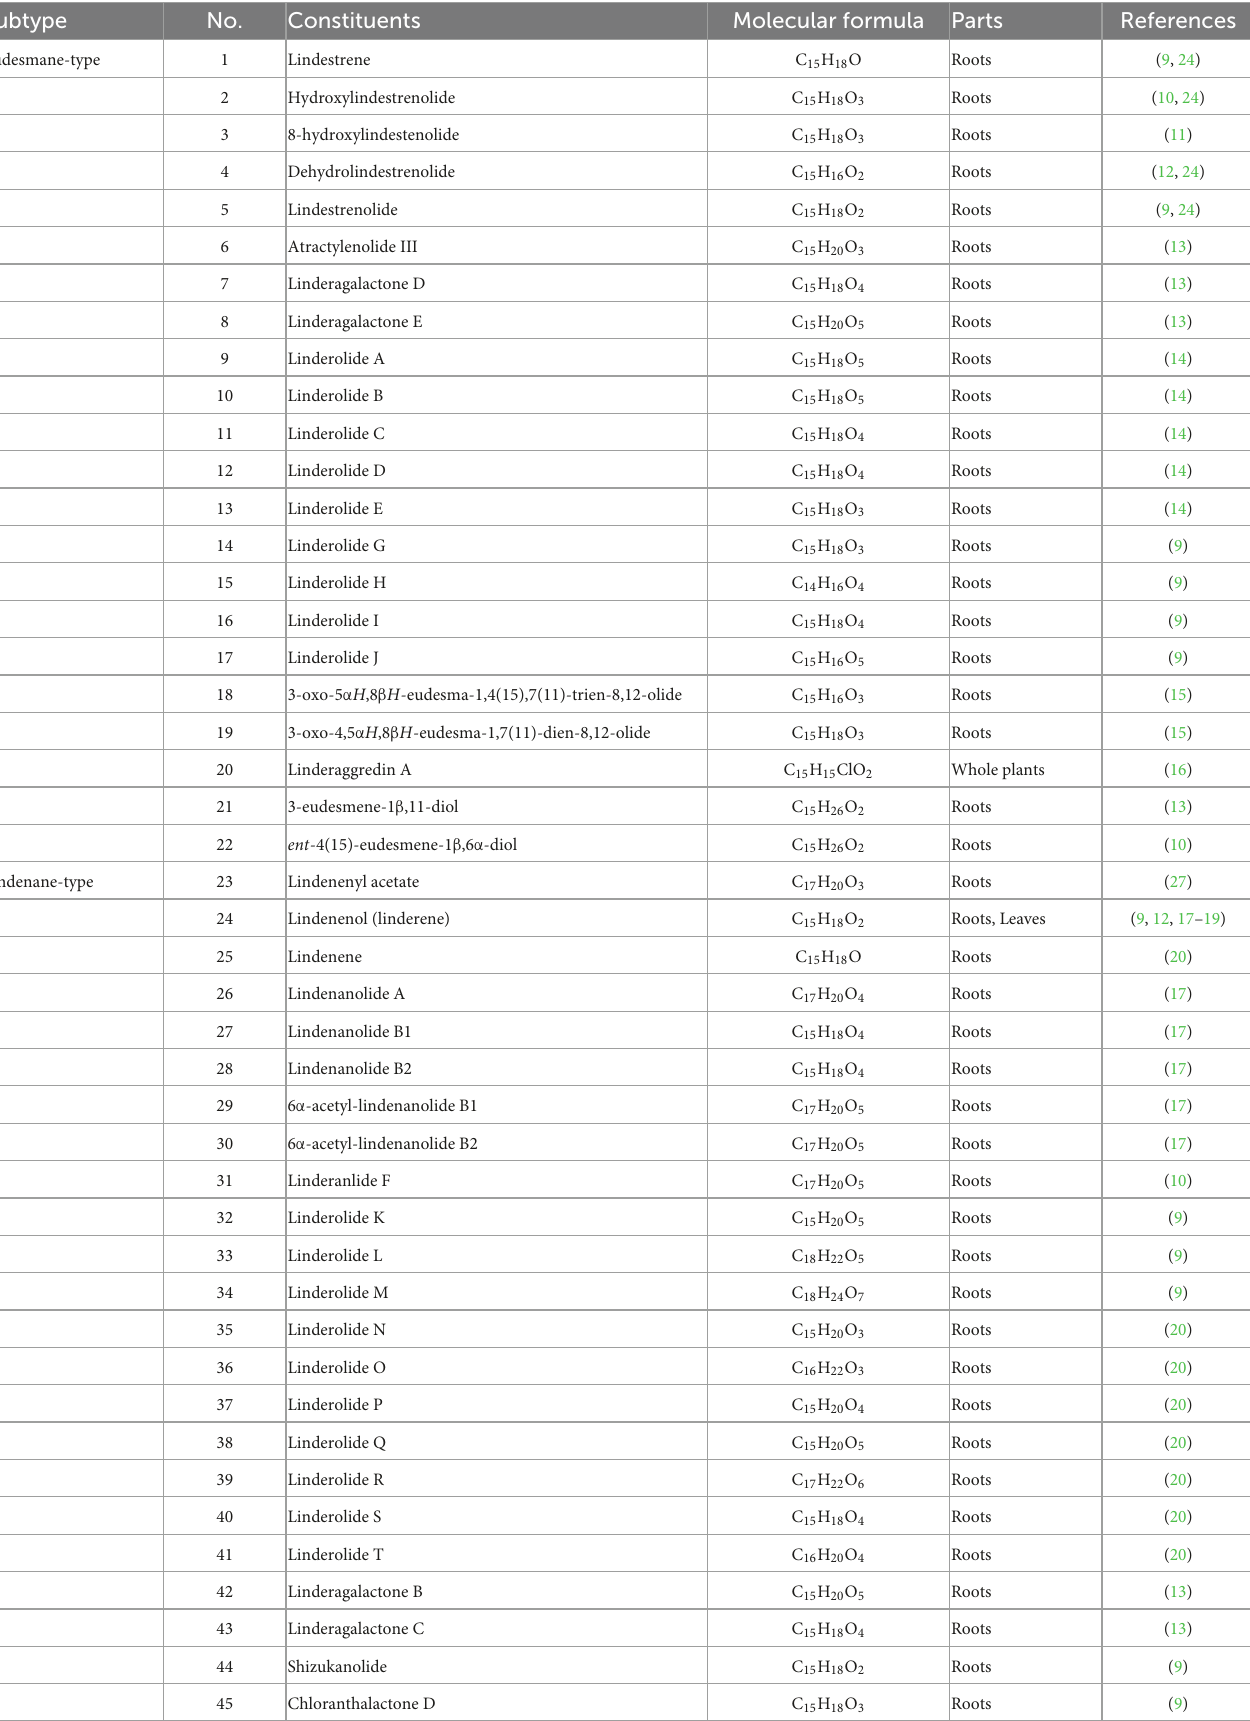
TABLE 1 Sesquiterpenoids isolated from L.